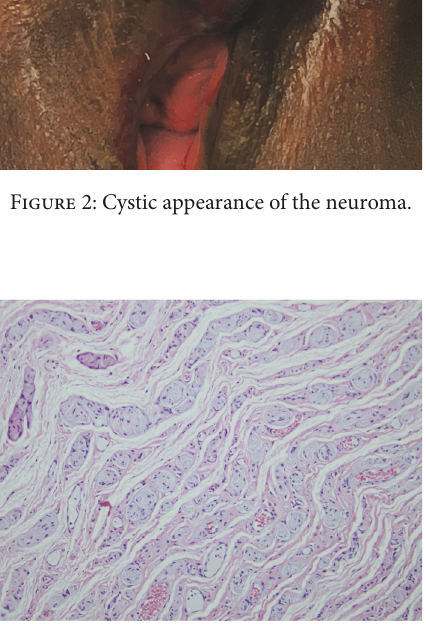
Figure 3: Microscopic view of the neuronal tissue identified within the cystic